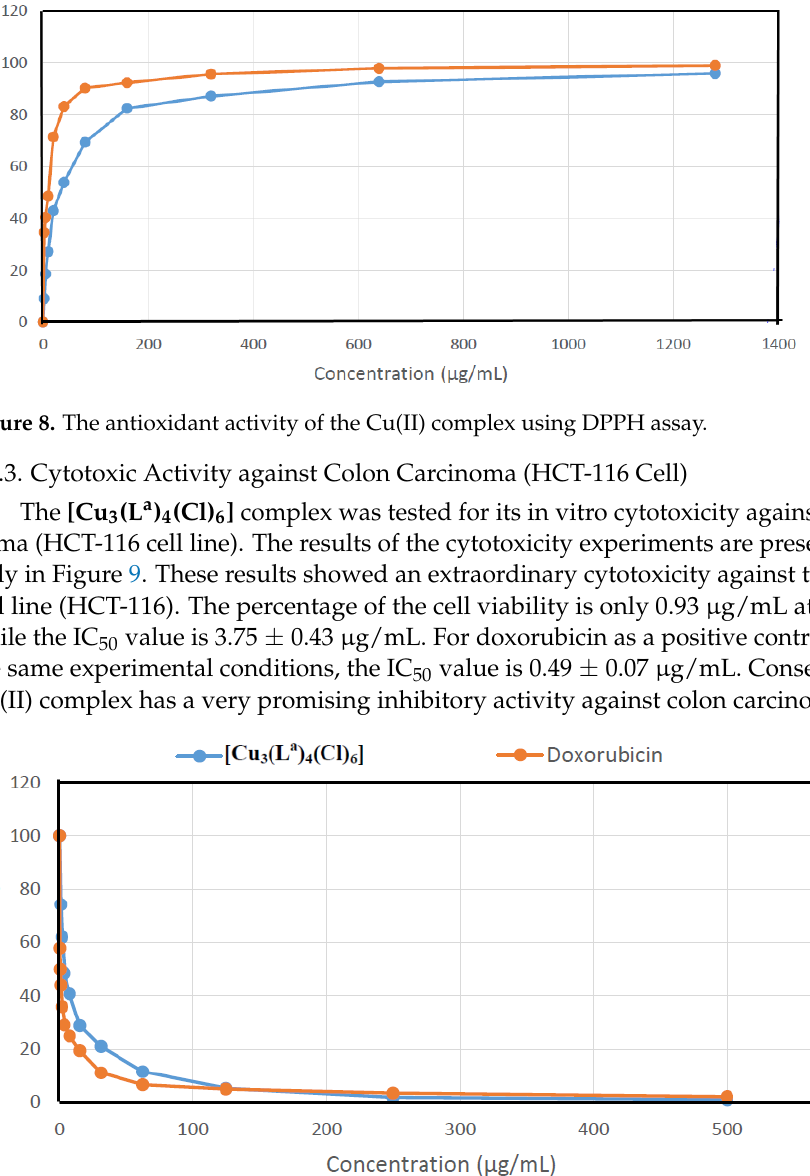
Figure 9. Cytotoxic activity of the [Cu 3 (L a ) 4 (Cl) 6 ] complex versus colon carcinoma (HCT-116 cell line).